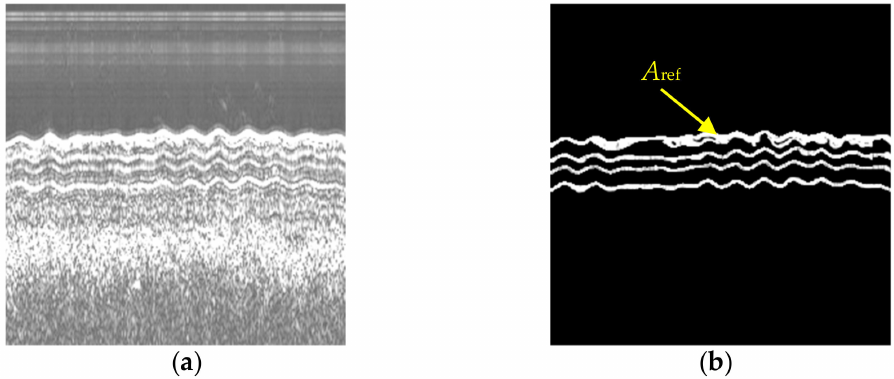
Figure 13. Pipeline echo intensity determination with the measured SBP data. ( a ) Waterfall image generated from measured SBP Data; ( b ) echoes from the interfaces between layers (the white part of the